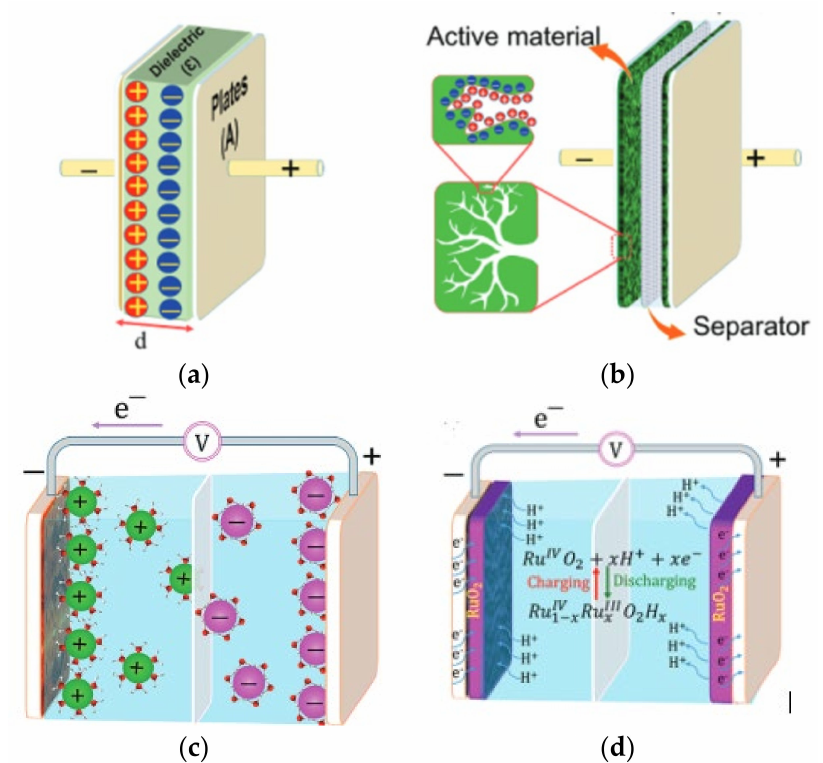
Figure 1. Schematics of ( a ) conventional capacitor, ( b ) supercapacitor, ( c ) electric double layer capacitor (EDLC), and ( d ) pseudocapacitor. Reproduced with permission from